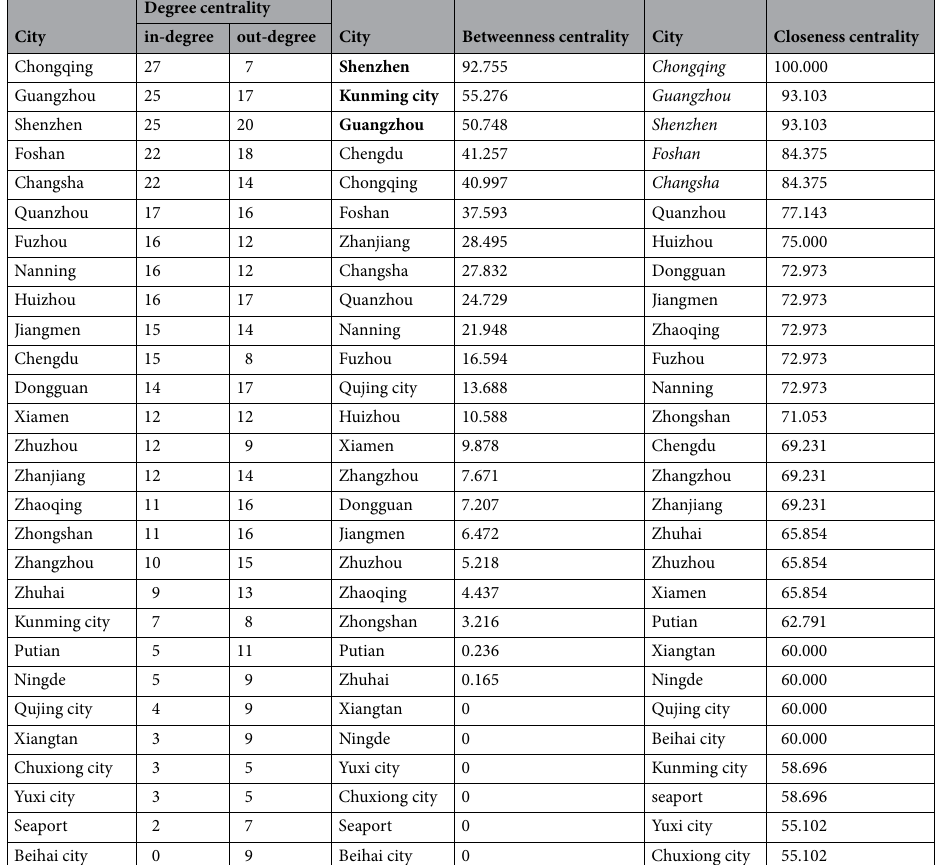
Table 2. The degree analysis of the traffic correlation network structure in the Pearl River Delta (2015). Bold indicate that the betweenness centrality of nodes is higher than 50, which means that these nodes are the hub nodes of the urban agglomeration. Unicom reflects the control ability of nodes in information transmission. Italic indicate that a node’s closeness centrality is greater than 80, which indicates that the node has strong information transmission ability and reflects the independence of the node in the process of information